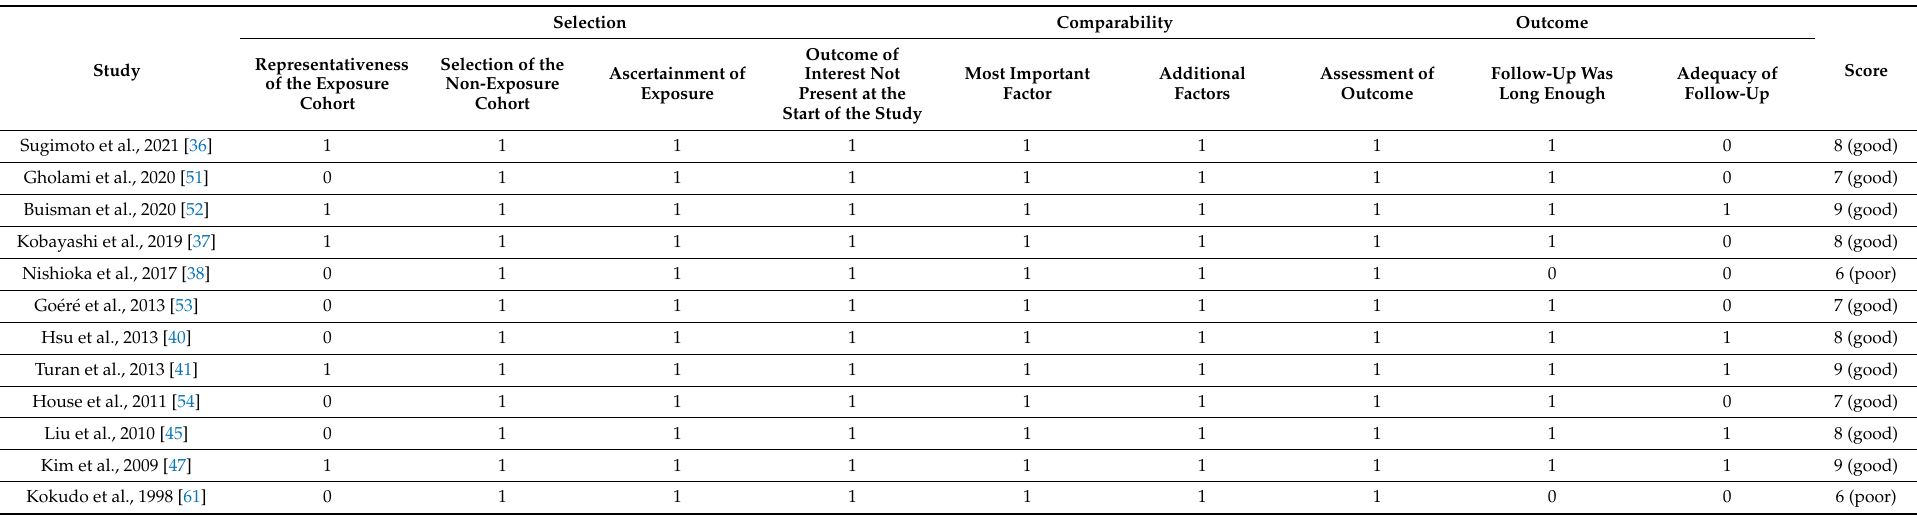
Table A3. Risk of bias assessment according to Newcastle–Ottawa scale for cohort studies.